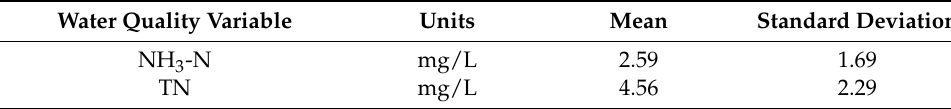
Table 1. Statistics of the water quality in the Beihu